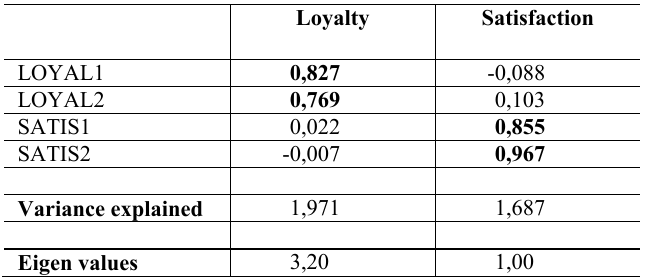
Table 6: Rotated factor loadings: Dependent